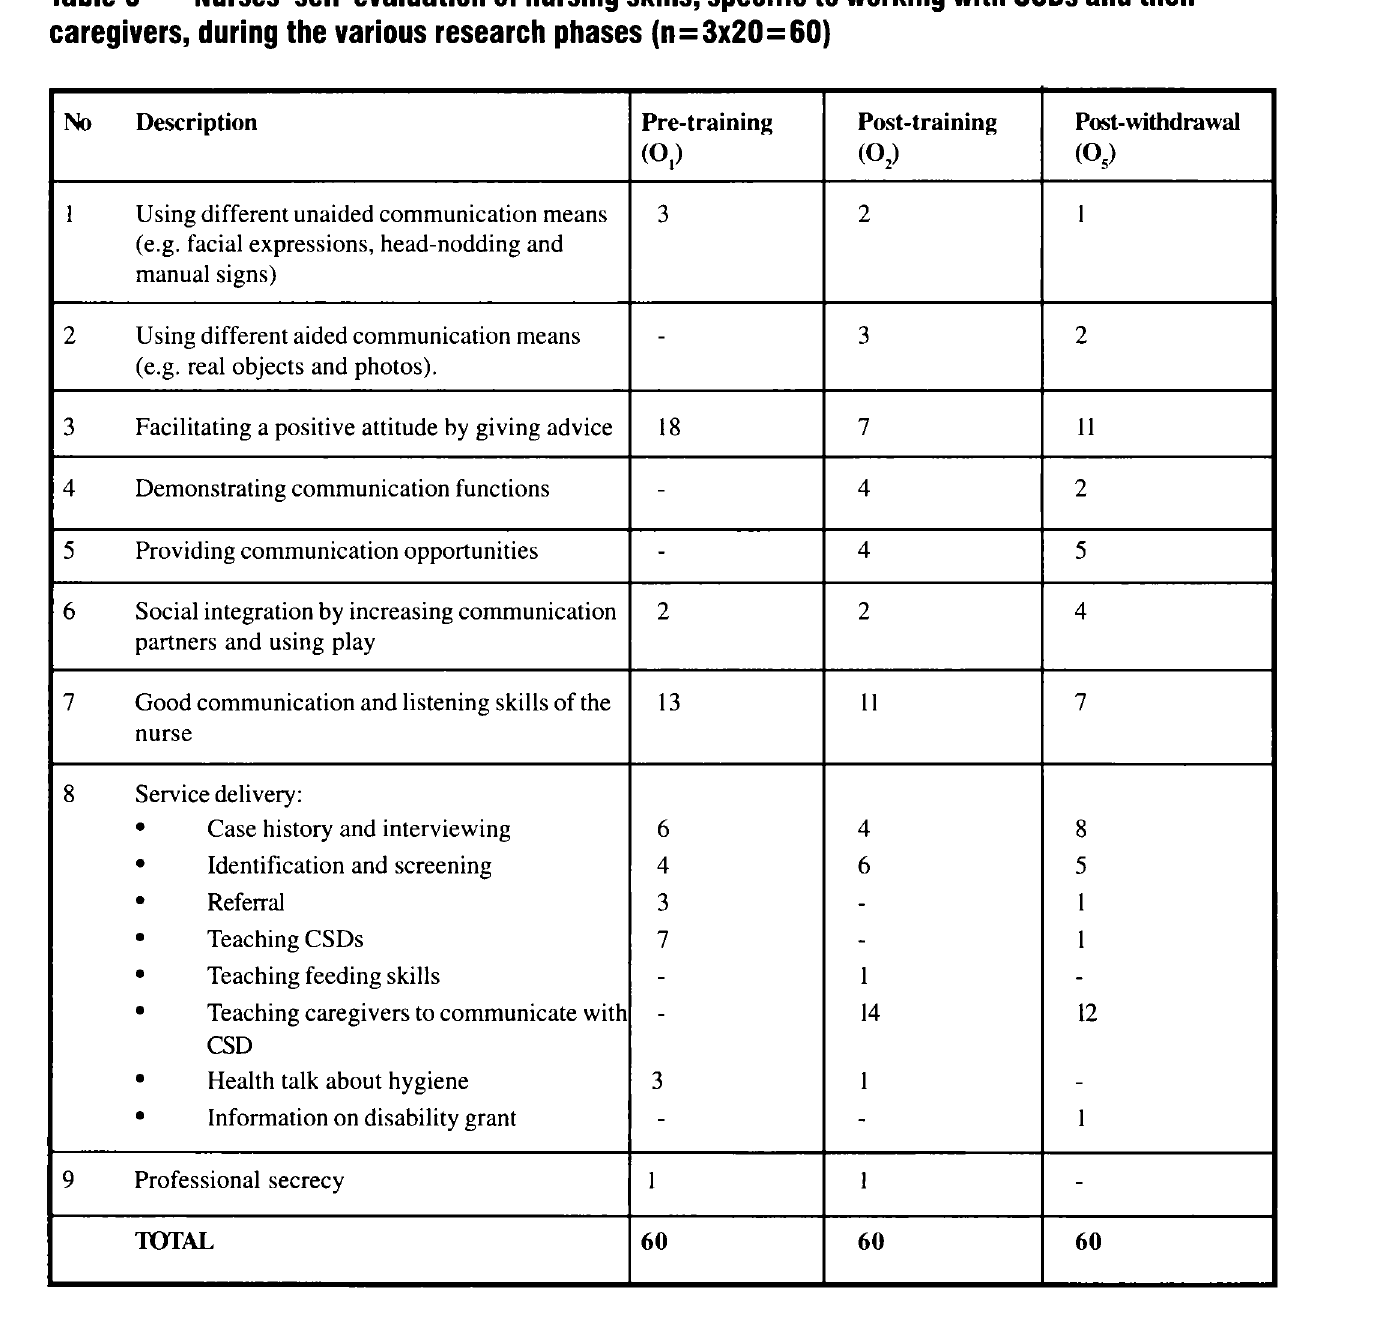
Nurses’ self-evaluation of nursing skills, specific to working with CSDs and their caregivers, during the various research phases (n =